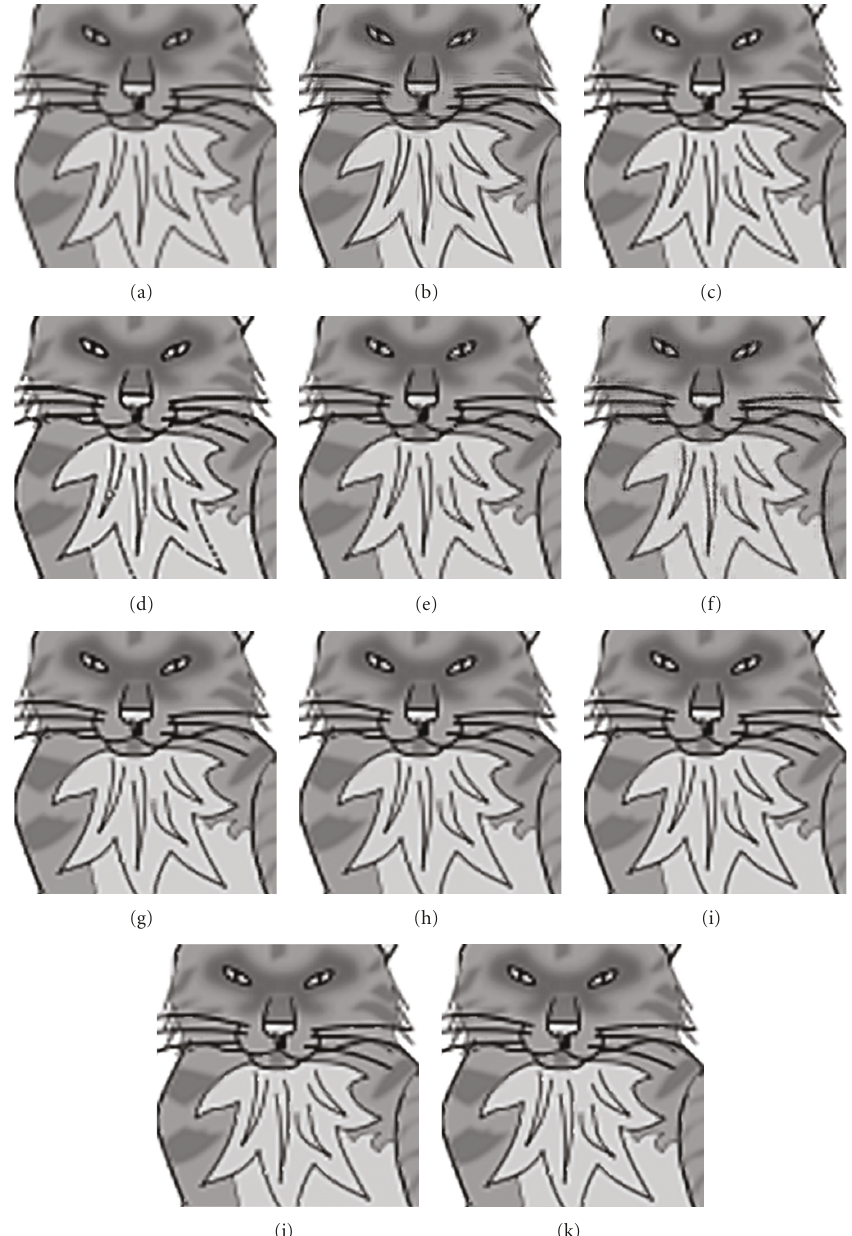
Figure 12: Portions of resolution enhanced “Gray cat” image by (a) bilinear; (b) bicubic; (c) edge-directed method ( M = 8) [12]; (d) ICBI [20]; (e) LMMSE-based method ( ζ = 1, ξ = 1 . 5) [17]; (f) SAI ( λ = 0 . 5) [18]; (g) NN-based method [16]; the proposed method utilized (h) bilinear kernel and (i) bicubic kernel without edge enhancement; (j) bilinear kernel and (k) bicubic kernel with edge enhancement.